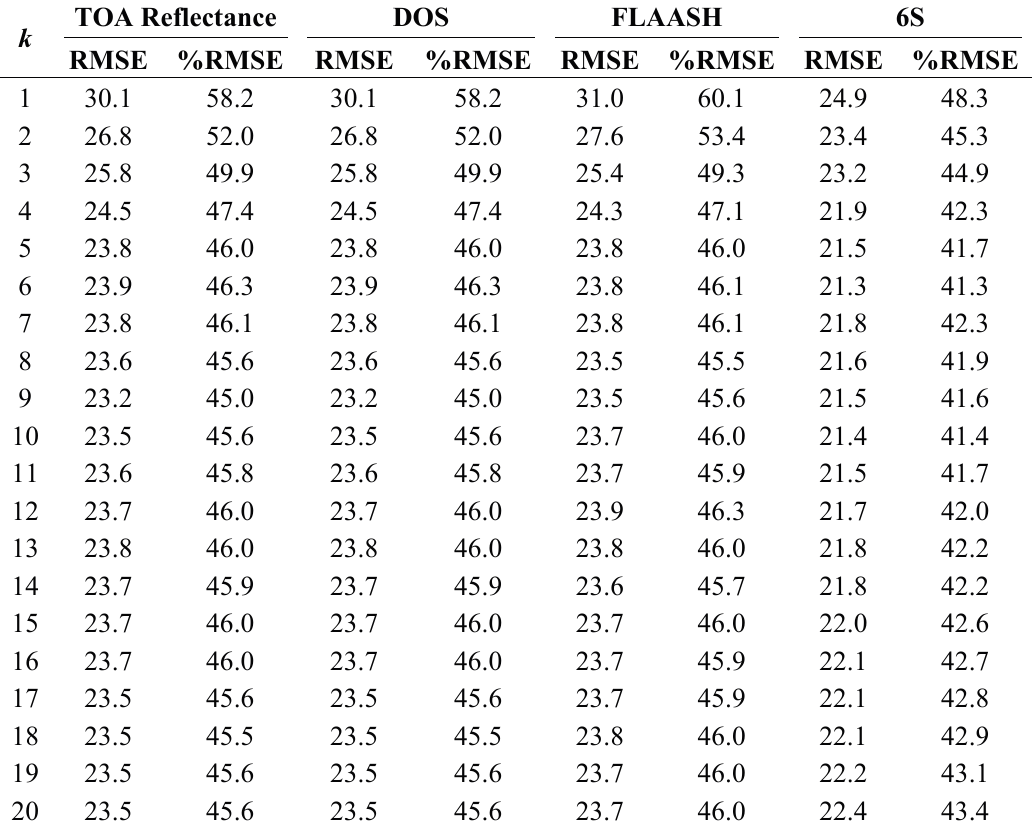
Table 5. Accuracy assessment results for 8th August 2010 Landsat ETM+ by four atmospheric cases: RMSE (unit: tonC/ha) and %RMSE (unit: